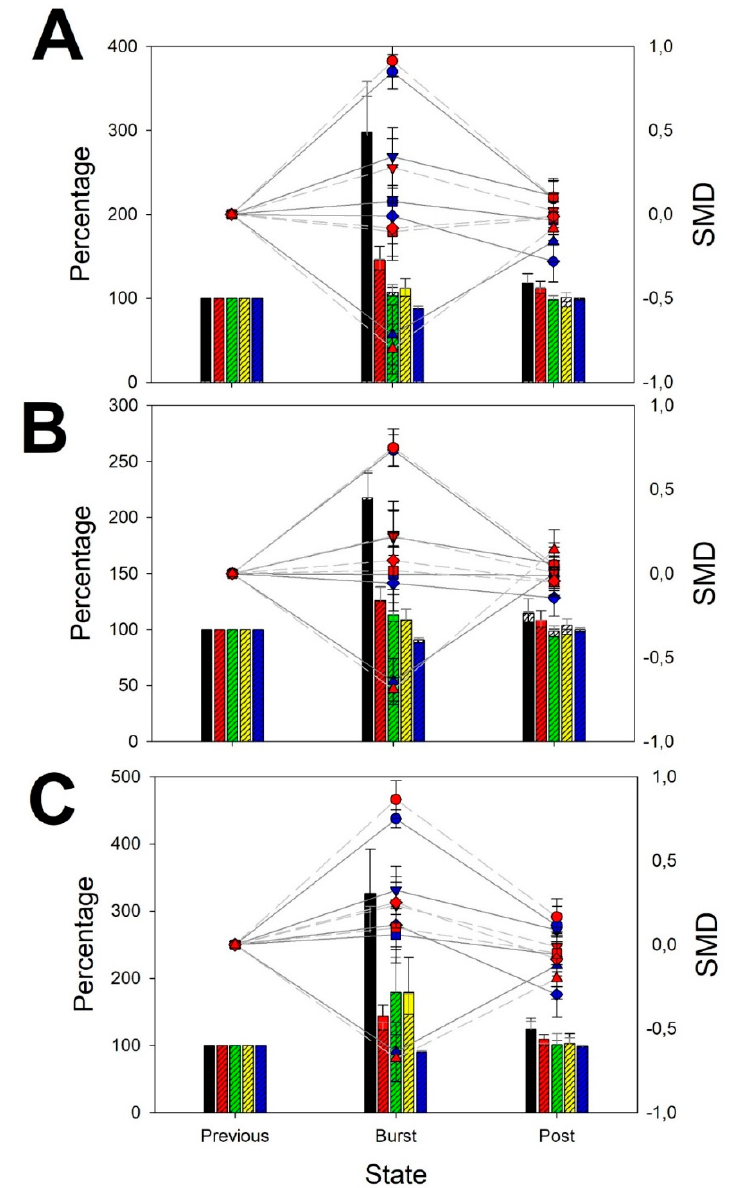
Figure 2. Normalized changes in power spectra and standardized mean difference (SMD) during BPA. ( A ) Frontal lobes; ( B ) Parieto-occipital lobes and ( C ) Temporal lobes. Bar graph (left y-axis): for every band and entropy, data from left (not-shaded bars) and right hemisphere (shaded bars) are superimposed ( δ = black, θ = red, α = green, β = yellow, Se = blue). Dot graph (right y-axis): SMD for every left (blue) and right hemisphere (red) for every band and entropy ( δ = circle, θ = down triangle, α = square, β = diamond, Se = up triangle).